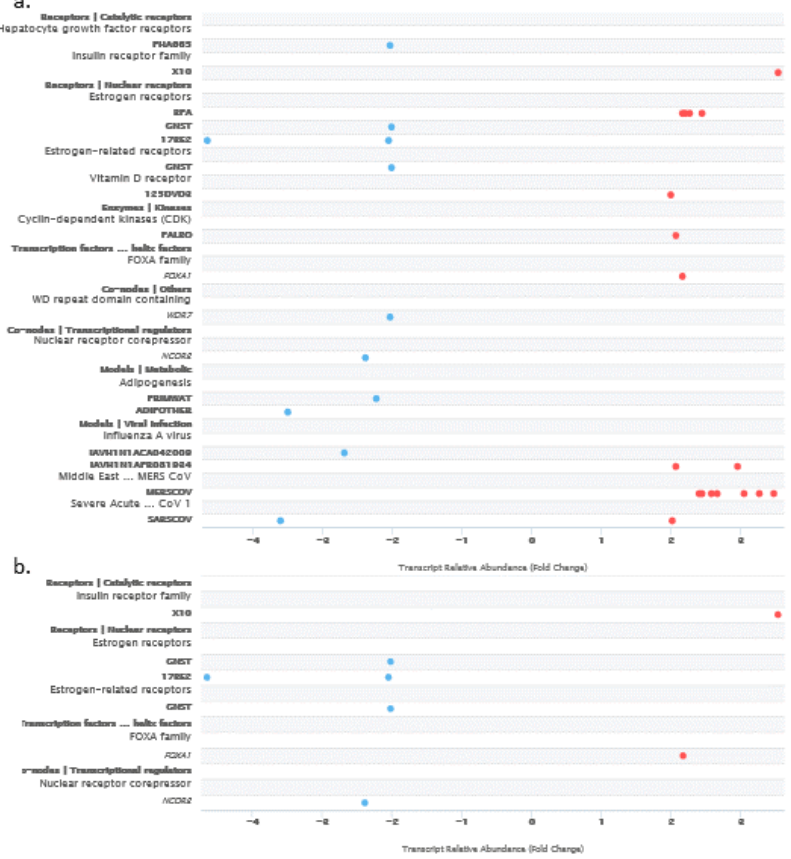
Figure 4. Receptor, enzyme, and transcription factor pathway nodes, small molecules, and viruses that regulate ACBD3 transcription. Blue dots represent repression of ACBD3 transcripts and red dots represent promotion of ACBD3 transcripts; the cut-off was set at a transcription fold change of at least 2 and a confidence interval of 99.9% or greater. ( a ) Factors that affect ACBD3 transcription across all normal tissues. ( b ) Factors that affect ACBD3 transcription in normal breast tissue.